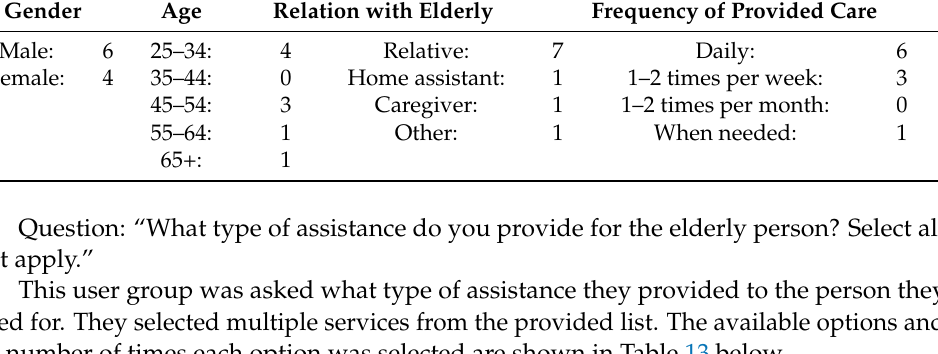
Table 13. Type of assistance provided to cared ones. Type of Assistance Provided Frequency Buying medicine and/or helping with medicine intake 7 Arranging visits to